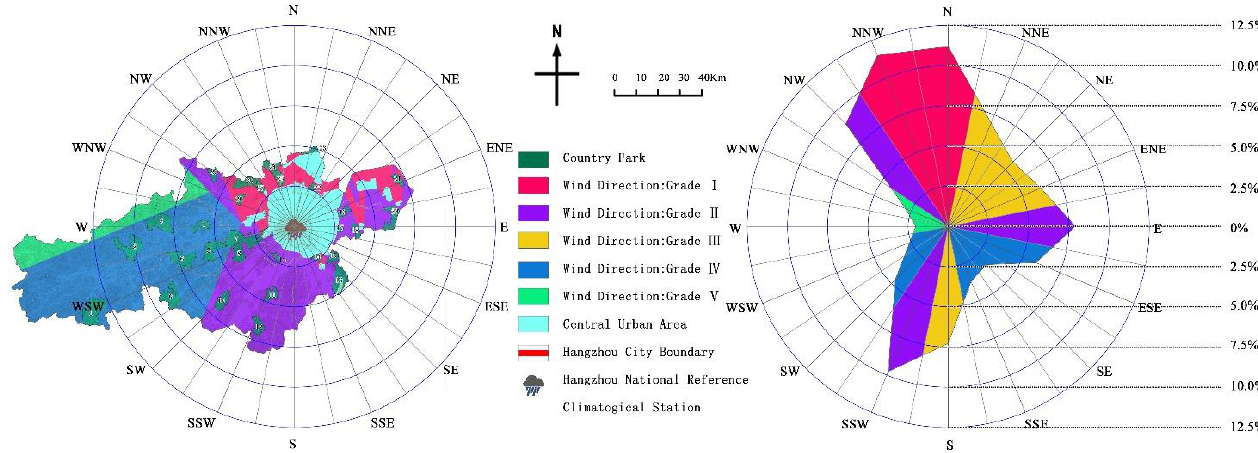
Figure 8. The wind direction distribution of country parks.